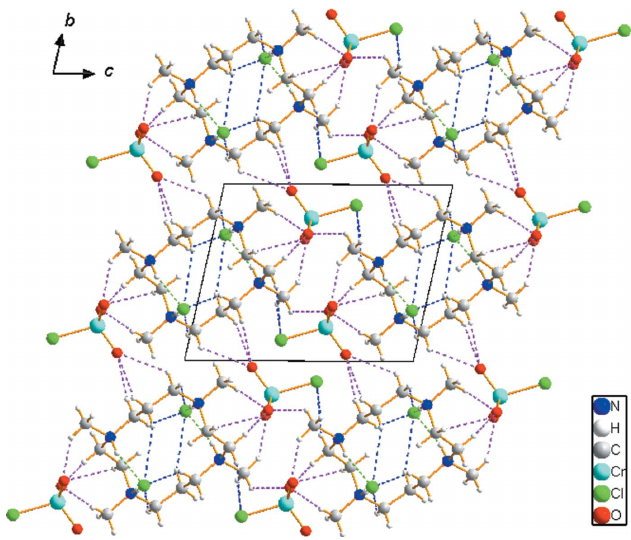
Figure 4 The crystal packing of (I), viewed perpendicular to the bc plane. Dashed lines represent N—H (cid:3)(cid:3)(cid:3) Cl (green), C—H (cid:3)(cid:3)(cid:3) O (pink) and C—H (cid:3)(cid:3)(cid:3) Cl (blue) hydrogen-bonding interactions (see Table 1 for details).